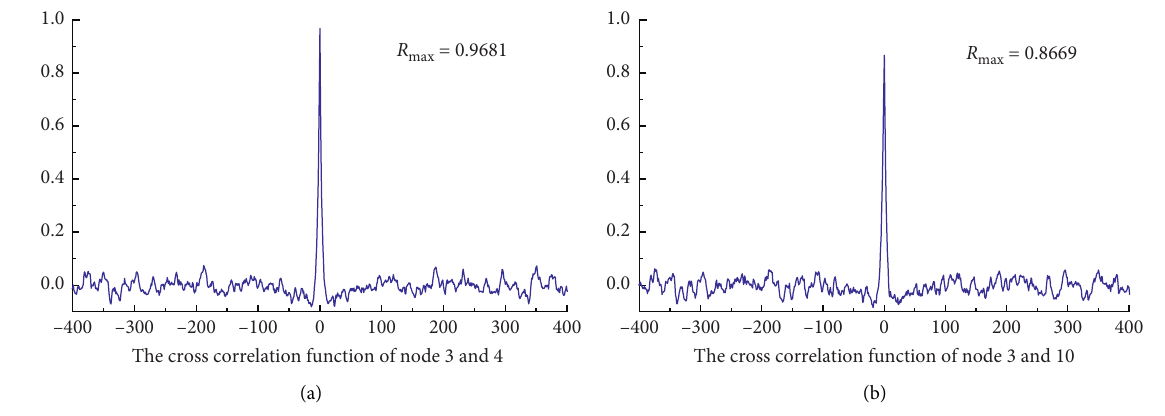
Figure 8: Normalized cross-correlation function of different nodes. (a) Cross-correlation function of points 3 and 4. (b) Cross-correlation function of points 3 and 10.